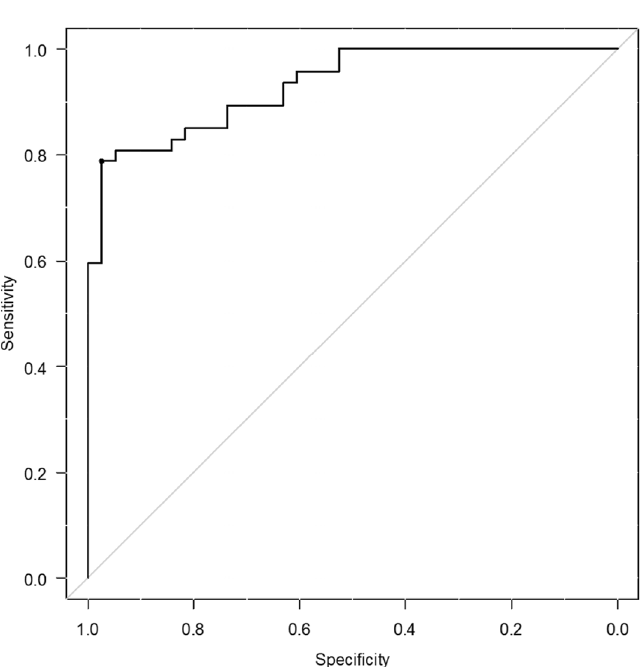
Figure 3. The cutoff value of the daily number of steps for determining walking independence. Cutoff value was 4286 steps (area under the curve = 0.914, sensitivity of 0.731, and specificity of